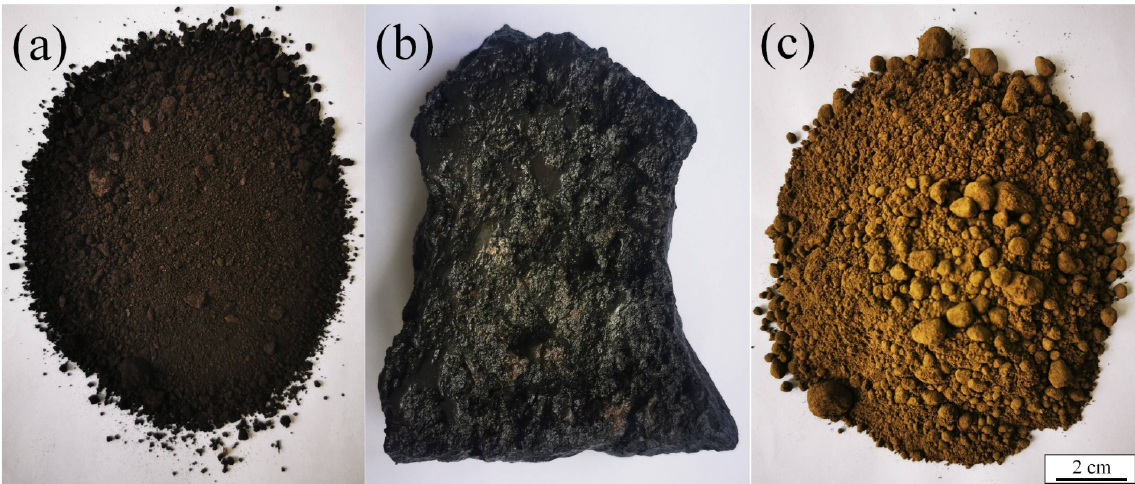
Figure 4. Images of feedstock ( a ), coagulum ( b ), and crude zinc powder ( c ).